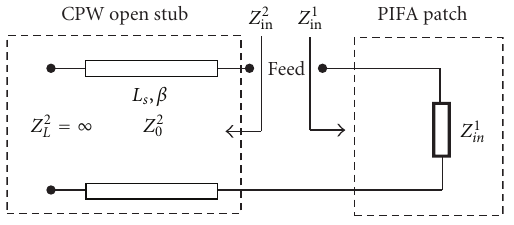
Figure 3: Transmission line model of the CPW open stub feed PIFA antenna.